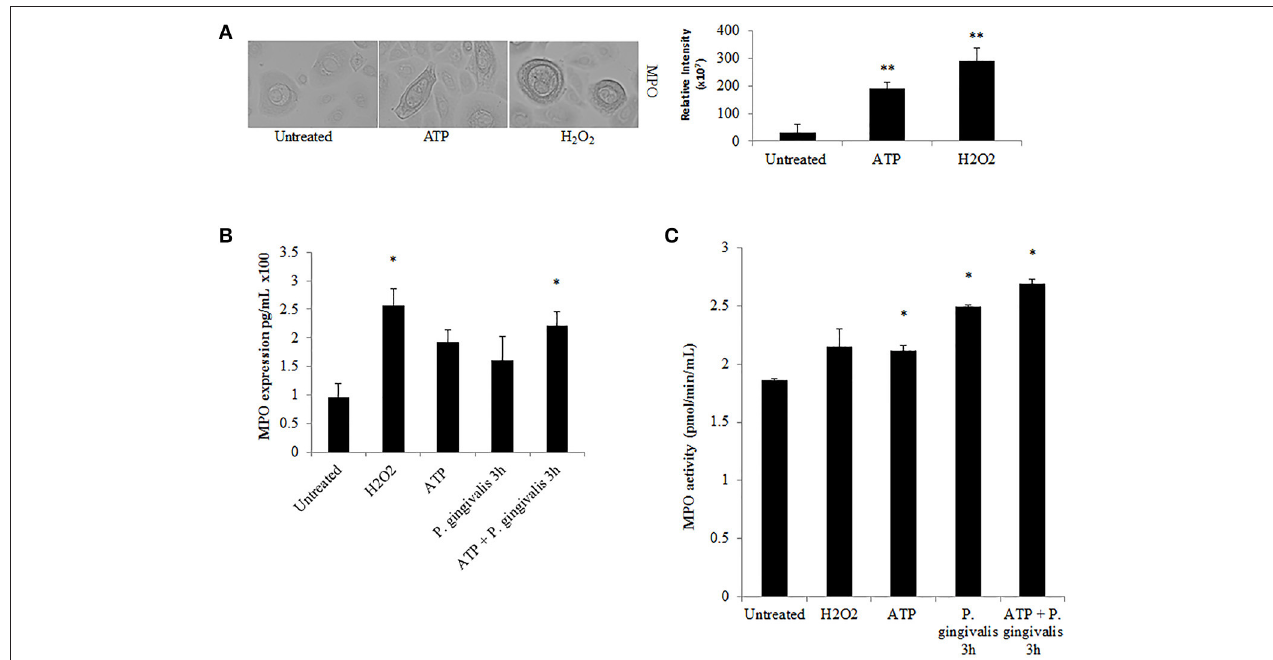
FIGURE 6 | Myeloperoxidase is functionally expressed in primary GECs and activity increases in response to ATP and P. gingivalis infection. (A) Immunoperoxidase staining of MPO in H 2 O 2 (100 µ M) and ATP (3 mM) cells at 40x magnification performed for visual detection. Image J was used to quantify the relative staining intensity and compared to untreated. N = 9, ** p < 0.01. (B) Quantitative ELISA measurement of MPO expression in primary GECs displayed as pg/mL in H 2 O 2 , ATP pre-treated, and P. gingivalis (MOI100) infected cells. N = 3, * p < 0.05 as compared to untreated. (C) MPO activity assay during ATP pre-treatment and P. gingivalis (MOI100) infection in primary GECs calculated based on the standard curve of activity tested empirically (see Methods Section). N = 3, * p < 0.05 as compared to untreated.